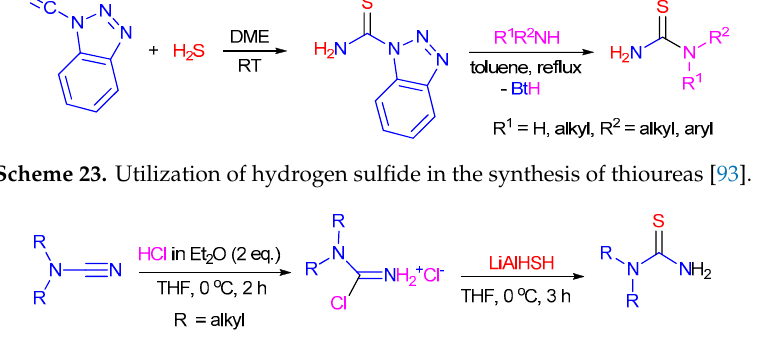
Figure 3. Ketoconazole thiourea derivative prepared by Tang and co-workers [96]. A relatively low explored synthetic strategy is based on the use of isocyanides. Zhu et al. described a Co(II)-catalyzed insertion of isocyanides into active N-H bonds of amines under ultrasound irradiation; the amino methylidyneaminium intermediates reacted readily with various nucleophiles including sulfur (to give thioureas) or water (yielding ureas) [97]. A series of aniline derivatives were tested with tert -butyl isocyanide to give 37–53% yield, and tryptamine with 4 different isocyanides gave products in 53–67%. The optimal reaction conditions included 20 mol% of